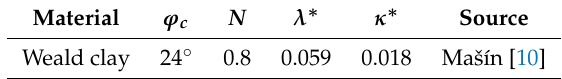
Figure 2. Barotropy in barodesy, figure modified from [19]: simulations with barodesy of CD triaxial tests with Weald clay with e ini = const. ( a ) mean stress - void ratio plot: highly overconsolidated samples (grayed area) dilate, normally and slightly overconsolidated samples contract under shearing. ( b ) mean stress - deviatoric stress plot: highly overconsolidated samples reach peak states which are higher than critical strength. ( c ) axial strain - stress ratio plot: highly overconsolidated samples reach higher stress ratios/mobilized friction angles than the critical friction angle. Table 1. Critical state soil mechanics parameters used for the calibration of